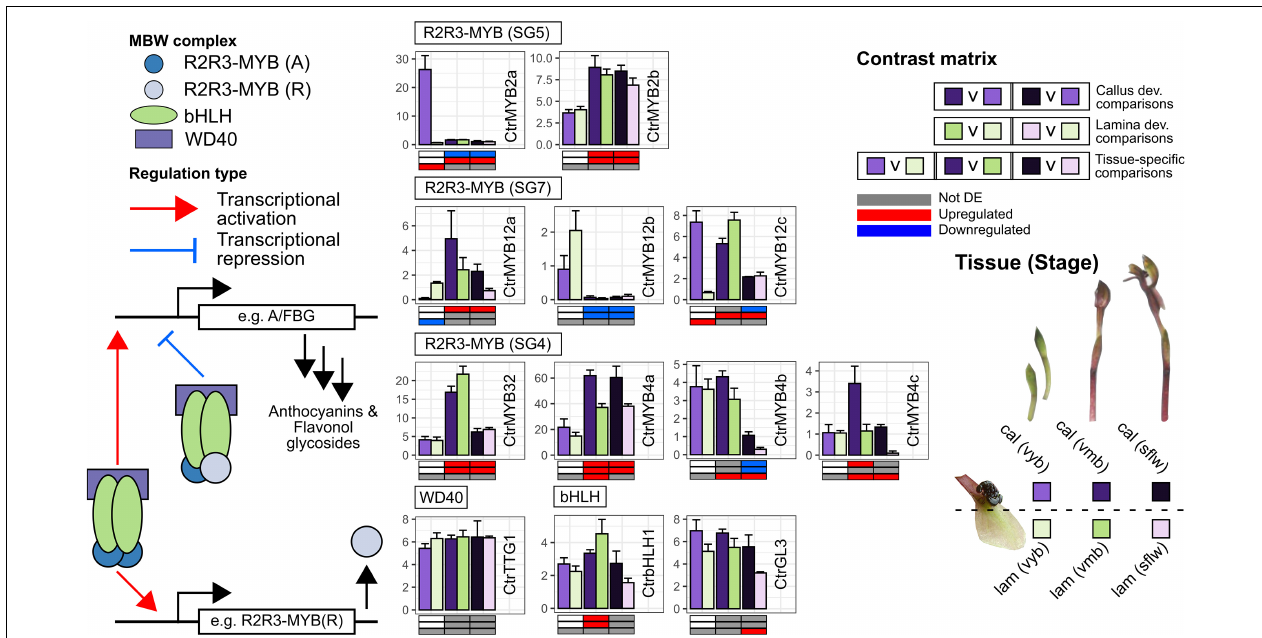
FIGURE 4 | Transcriptional regulation of anthocyanin and flavonol glycoside pathway genes in the callus and labellum tissues of Chiloglottis trapeziformis during flower development. Bars depict the average ( ± s.e.) normalized expression values (FPKM) of putative transcriptional regulatory genes encoding relevant R2R3-MYB, basic-helix-loop-helix (bHLH), and WD40 repeat (WDR) proteins in the calli and labellum lamina tissues of very young buds ( vyb ), very mature buds ( vmb ), and mature sunflowers ( sflw ). A/FBG indicate shared flavonoid as well as anthocyanin/flavonol glycoside biosynthetic pathway genes. Various shades of purple and green depict the relevant color callus and labellum lamina tissues at various flower developmental stages. The contrast matrix indicates the differential expression outcomes based on comparisons in Supplementary Figure 1 . Red, blue, and gray indicate significant upregulation (FDR < 0.05, log 2 FC > 0.5), downregulation (FDR < 0.05, log 2 FC < –0.5), and no significant differential expression in selected comparisons,